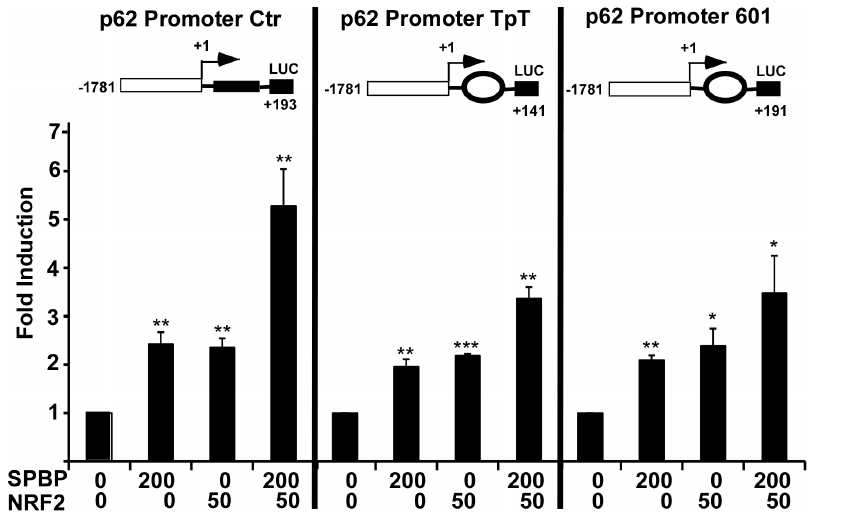
Figure 4. Nucleosome positioning sequences impair the synergistic effect of NRF2 and SPBP on the p62 promoter. Reporter constructs (60 ng) containing the indicated nucleosome position sequences inserted downstream of the transcription start site of p62 promoter were transfected into HEK293 cells together with the indicated amounts of expression plasmids for SPBP and/or NRF2. The luciferase activity of the promoter constructs cotransfected with empty expression plasmids was set to 1. The data represent the mean of three independent experiments with standard deviations, each performed in triplicate (***p , 0.001, **p , 0.01, *p , 0.05).